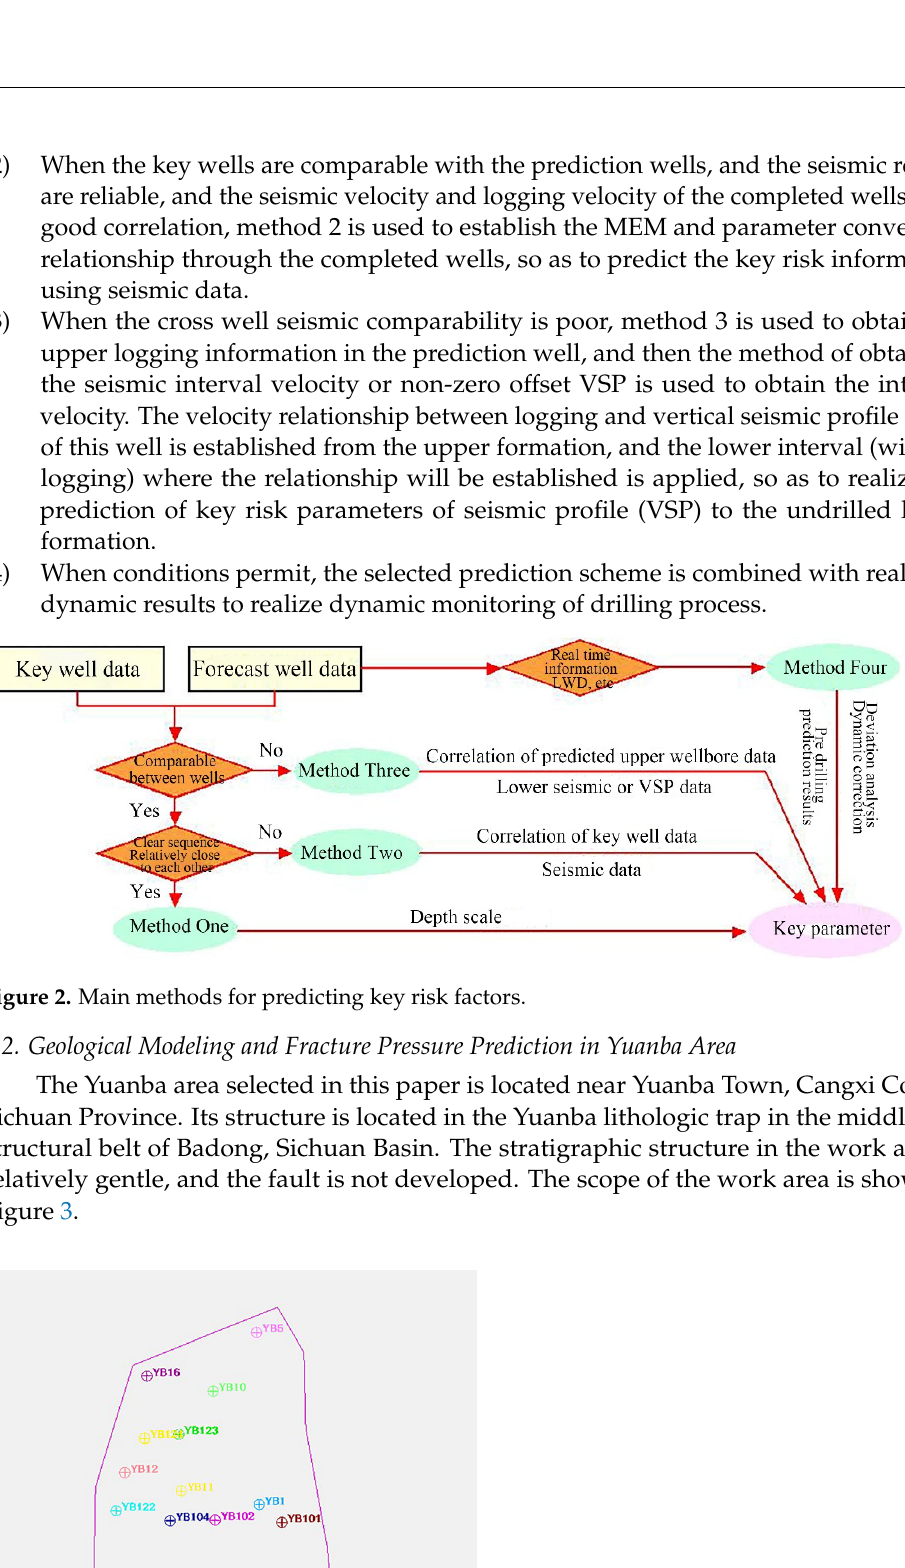
Figure 4. Structural level model. Figure 5. Fracture pressure model.